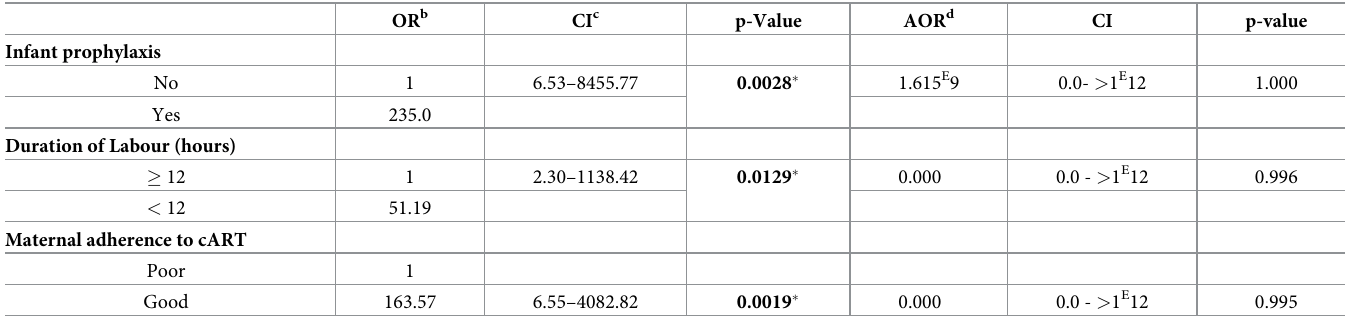
Table 6. Bivariate and multivariable analysis of determinants of MTCT a